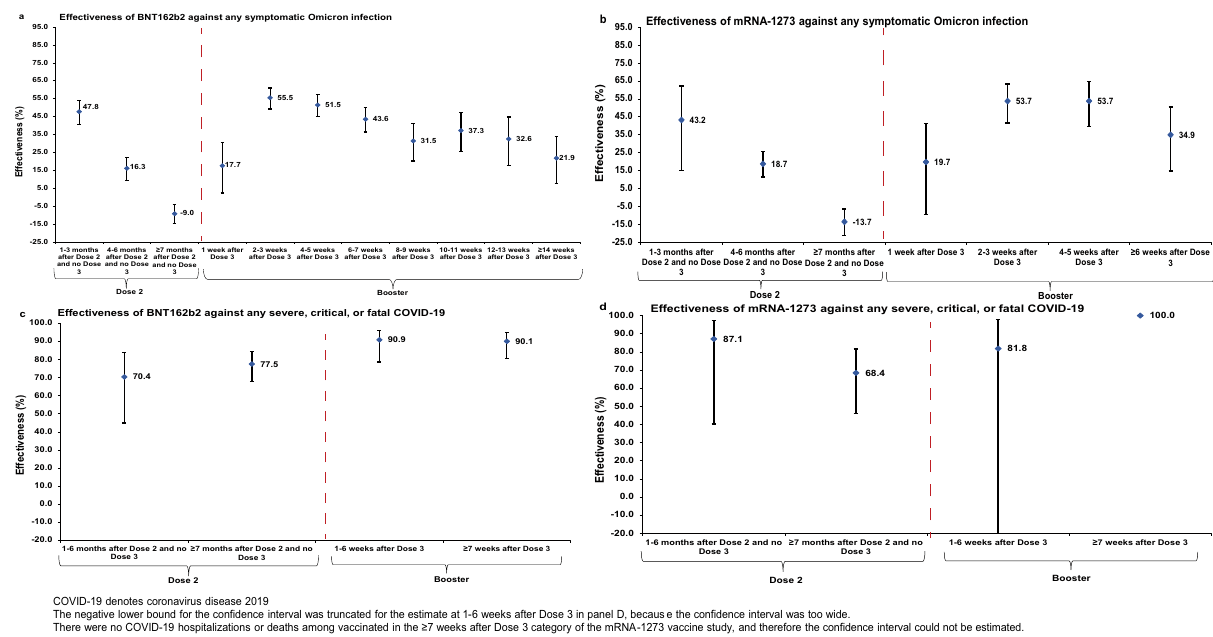
Fig. 4 Effectiveness of mRNA vaccines against any symptomatic SARS-CoV-2 Omicron infection regardless of subvariant and against severe COVID- 19. Effectiveness of the BNT162b2 and mRNA-1273 vaccines against any symptomatic SARS-CoV-2 Omicron infection regardless of subvariant (panels a and b, respectively) and against any severe 9 , critical 9 , or fatal 10 COVID-19 due to an Omicron infection ( c , d , respectively). a Includes 39,855 and 23,814 biologically independent samples for cases and controls, respectively, ( b ) includes 21,810 and 13,288 biologically independent samples for cases and controls, respectively, ( c ) includes 268 and 692 biologically independent samples for cases and controls, respectively, and ( d ) includes 164 and 404 biologically independent samples for cases and controls, respectively. Data are presented as effectiveness point estimates. Error bars indicate the corresponding 95% con fi dence